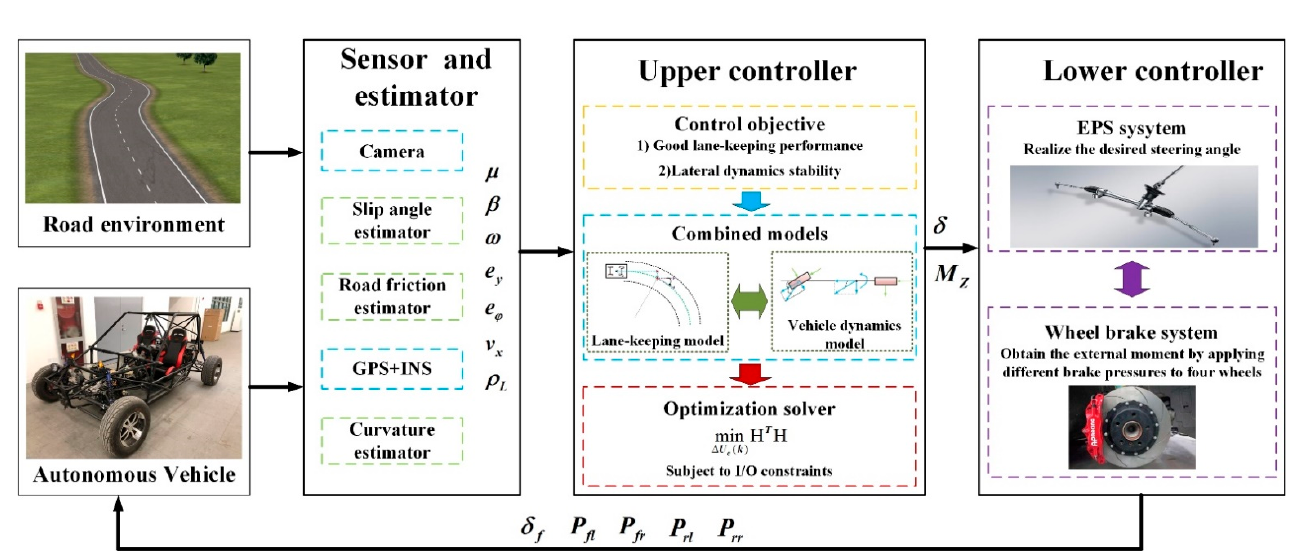
Figure 1. Overall structure of proposed LKS. Algorithm 1: The brief processing of proposed LKS controller